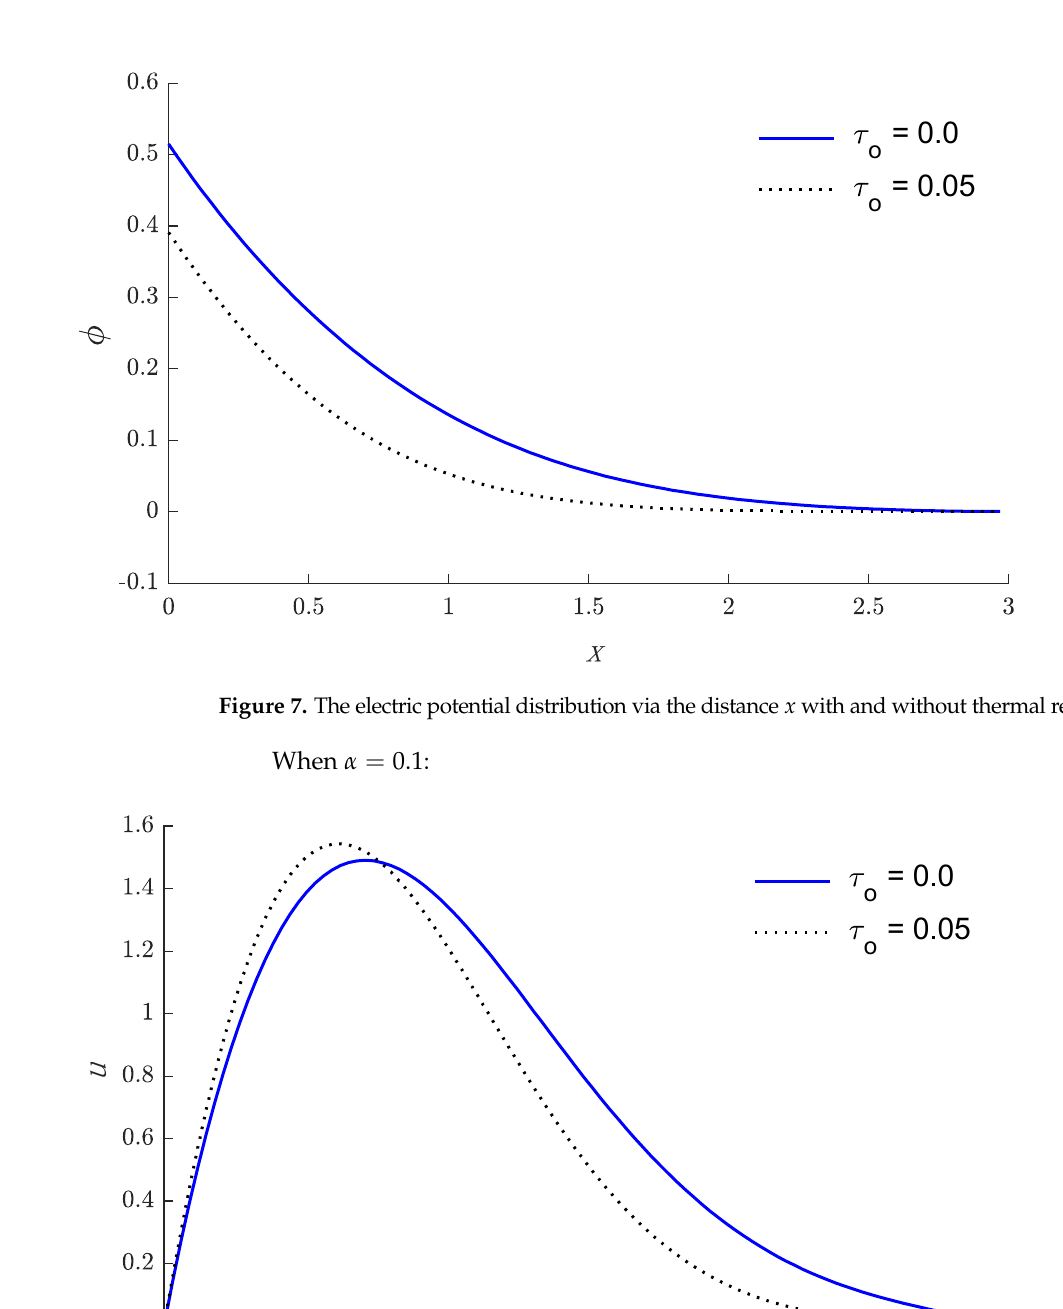
Figure 6. The temperature distributions via the distance 𝑥 with and without thermal relaxation time. When 𝛼 = 0.1 :